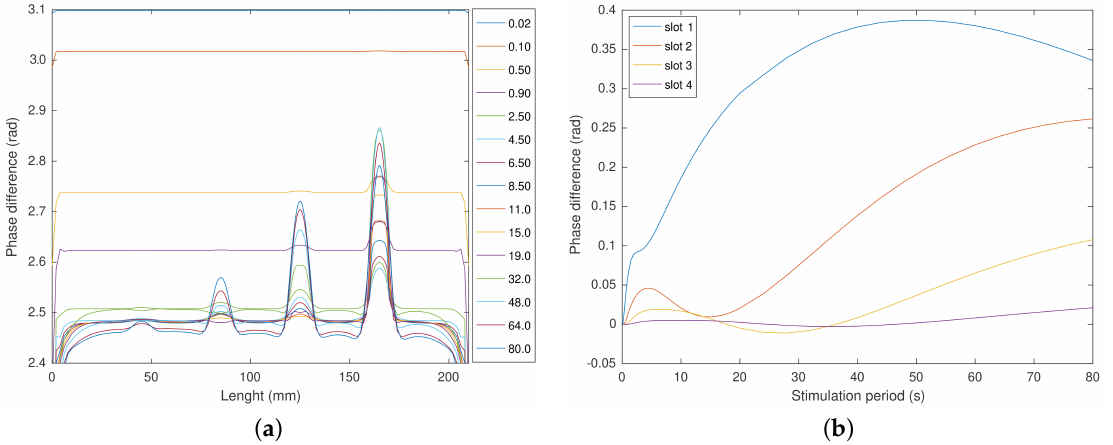
Figure 11. Phase delay and difference function of the cycle period. ( a ) Phase delay of the stimulation surface after 15 cycles. ( b ) Phase difference for periods from 0.02 to 80 s per